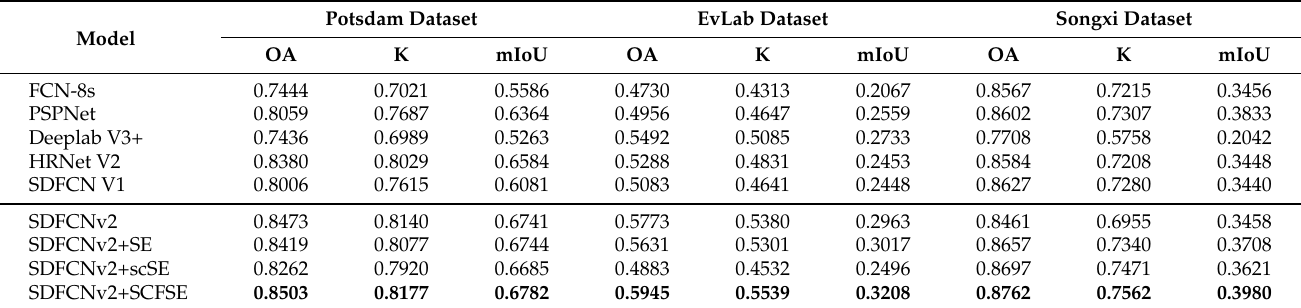
Table 3. Performances of different models and SE modules on three experiment datasets.